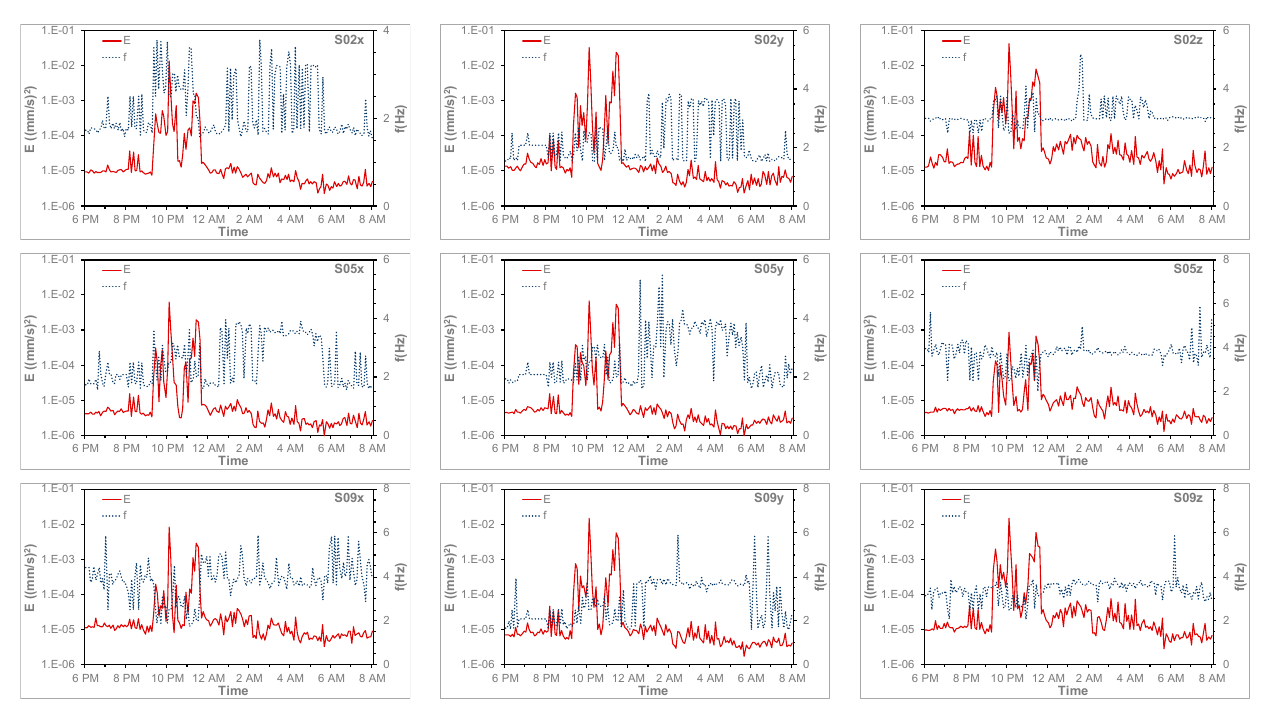
Figure 8. Energy and first resonance frequency in the three directions at S02, S05, and S09.